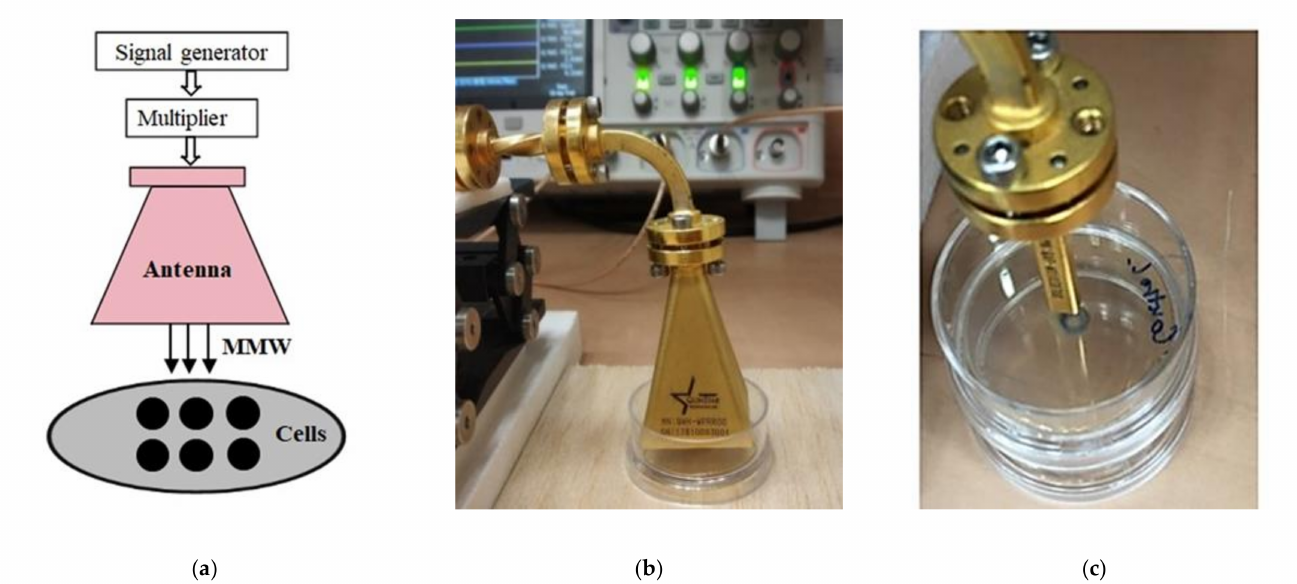
Figure 5. Block diagram of the experimental setup for irradiation and pictures of the pyramidal horn antenna and waveguide. ( a ) Schematic presentation of irradiating system. ( b ) Picture of a pyramidal antenna. ( c ) Picture of a